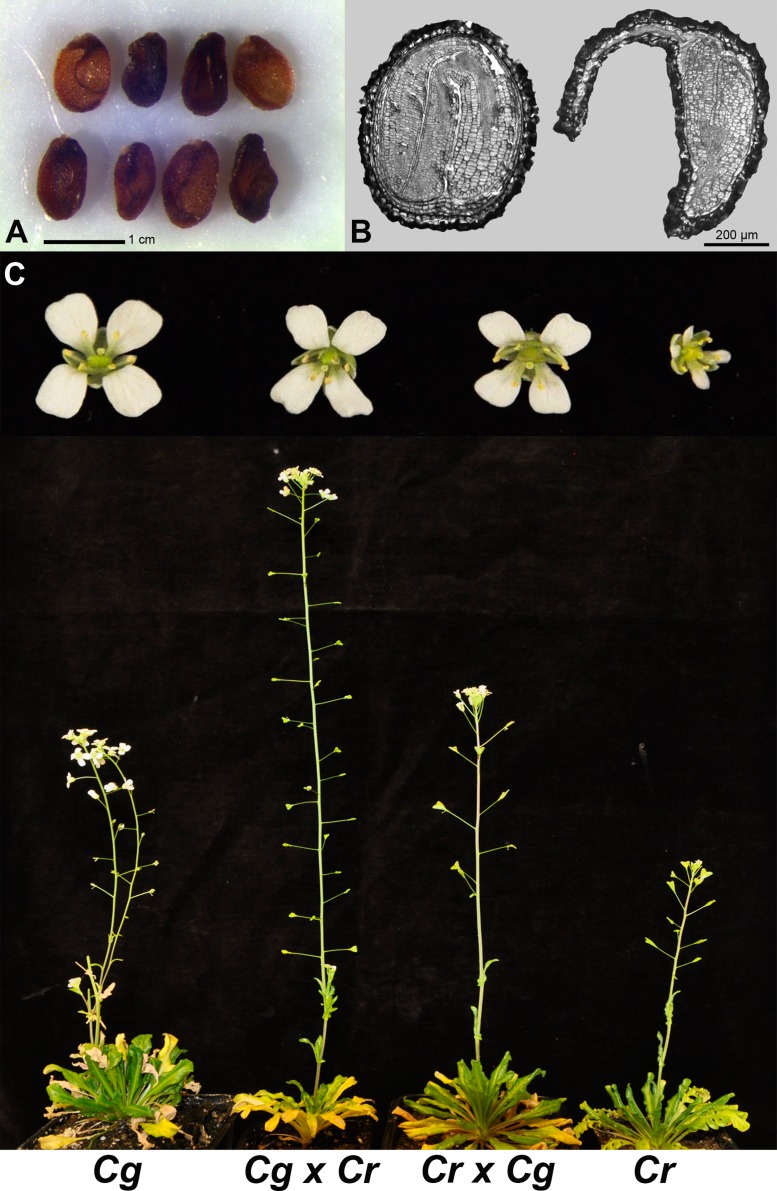

C. rubella × C. grandiflora hybrid embryos are viable, revealing a major role of endosperm defects in hybrid seed incompatibility.(A) C. rubella × C. grandiflora hybrid seeds at 13 days after pollination (DAP). (B) Section through seeds derived from crosses of C. rubella × C. rubella (left) and C. rubella × C. grandiflora (right) at 13 DAP. The sections reveal that hybrid embryos reach the torpedo stage at which development arrests. (C) Comparison of adult plants of all crosses (C. grandiflora × C. grandiflora (Cg), C. grandiflora × C. rubella (Cg × Cr), C. rubella × C. grandiflora (Cr × Cg), C. rubella × C. rubella (Cr)). Flower phenotypes of the respective genotypes are shown on top.